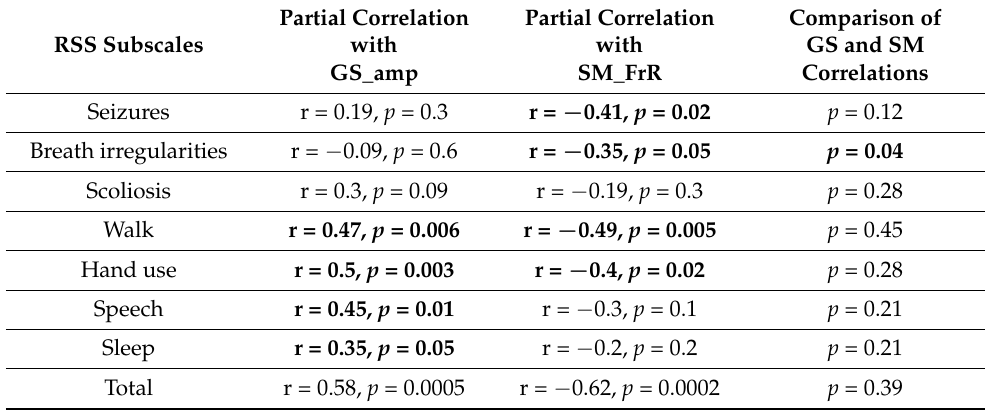
Table 5. Partial correlation of age and RSS scales with mean amplitude of general slowing (GS_amp) and frequency rate of sensorimotor rhythm (SM_FrR). Comparison of correlations is estimated for dependent samples according to [31]; single-sided testing. Significant differences are presented in bold. Comparison of Partial Correlation Partial Correlation GS and SM with RSS Subscales with SM_FrR GS_amp